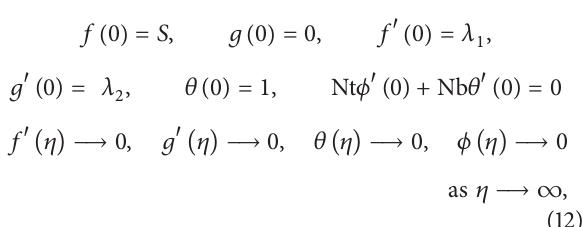
Figure 2: Variation of the skin friction coefficient in 𝑥 -direction with 𝜆 1 for different values of 𝑆 when 𝜆 2 = 1 .